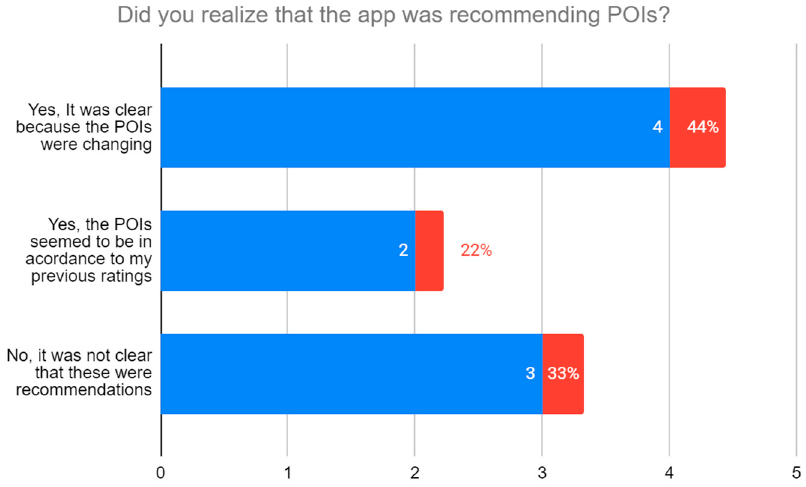
Figure 7. User responses to whether the participants realized the app was recommending POIs.